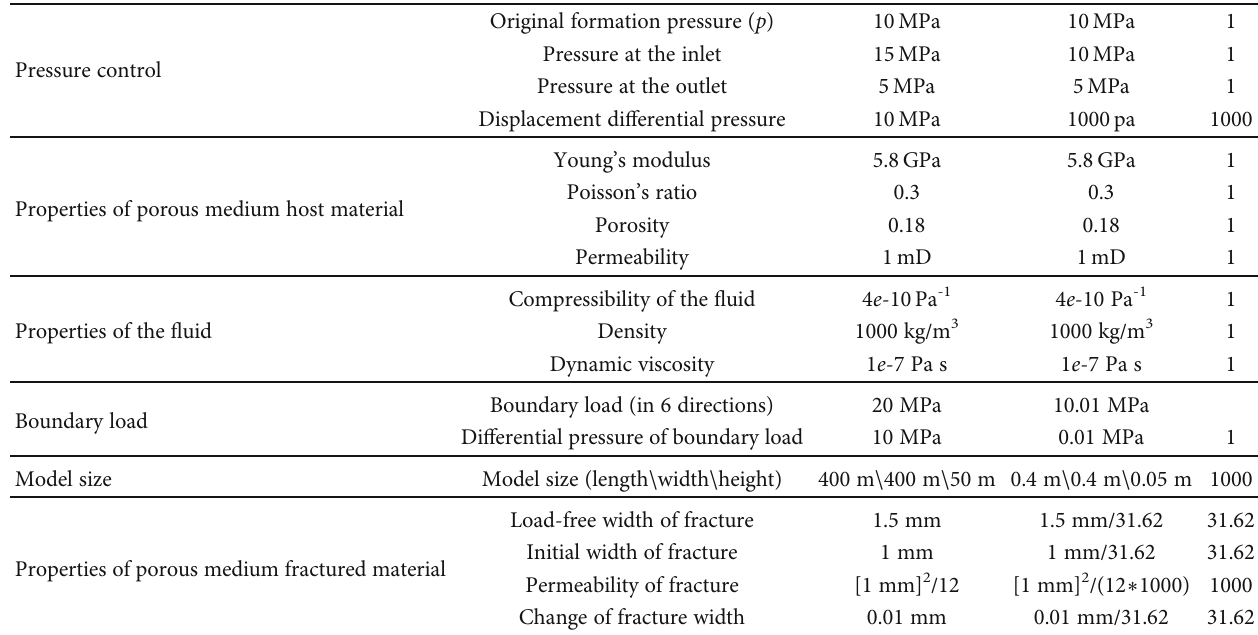
Table 2: Physical parameters of prototype and